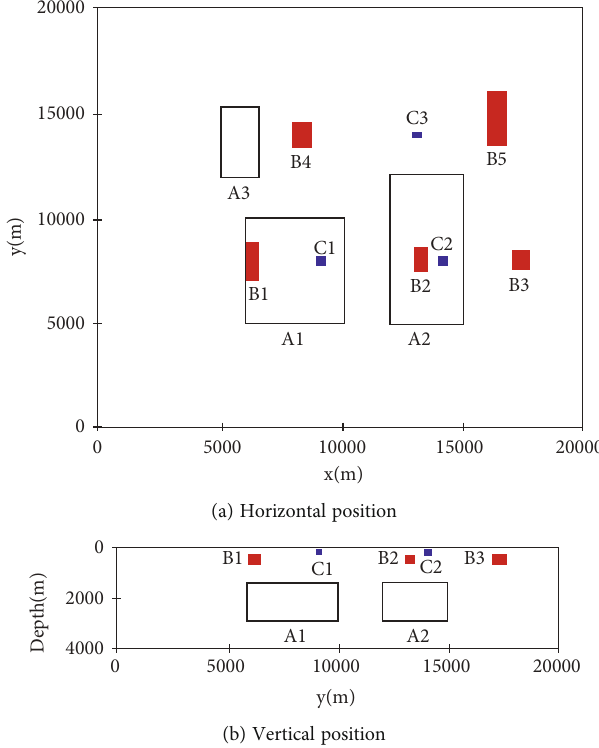
Figure 1: Forward modeling of geological body